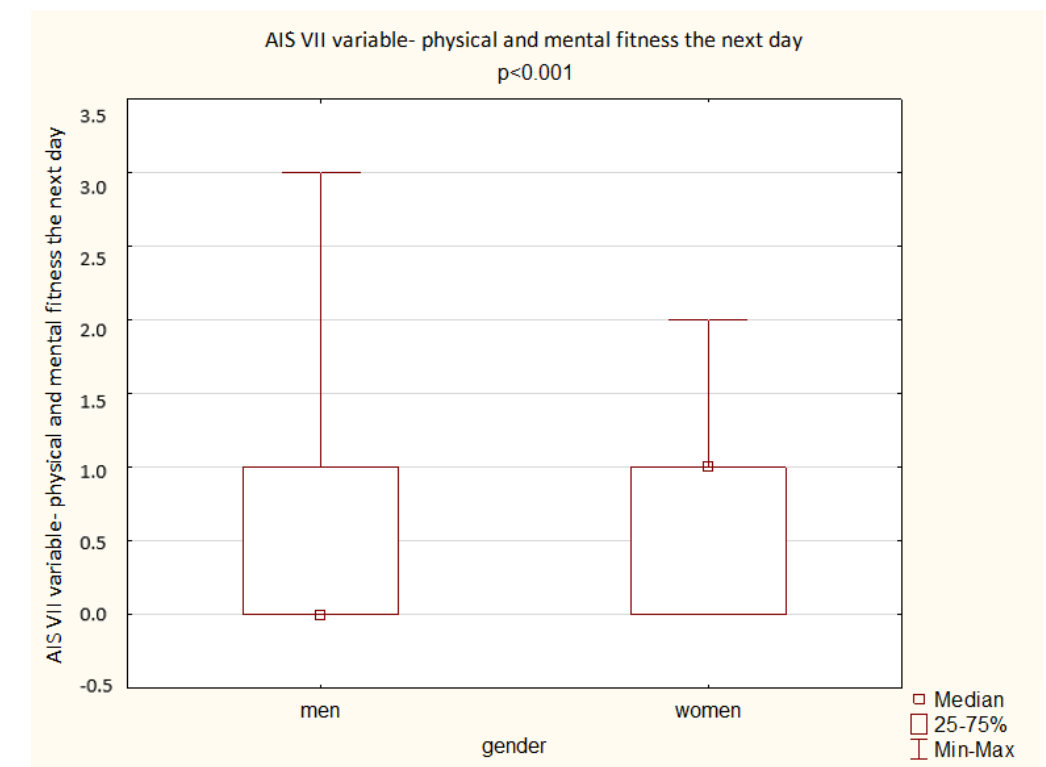
Figure 4. Patient results in the AIS VI variable — well-being the next day (Mann – Whitney U test).